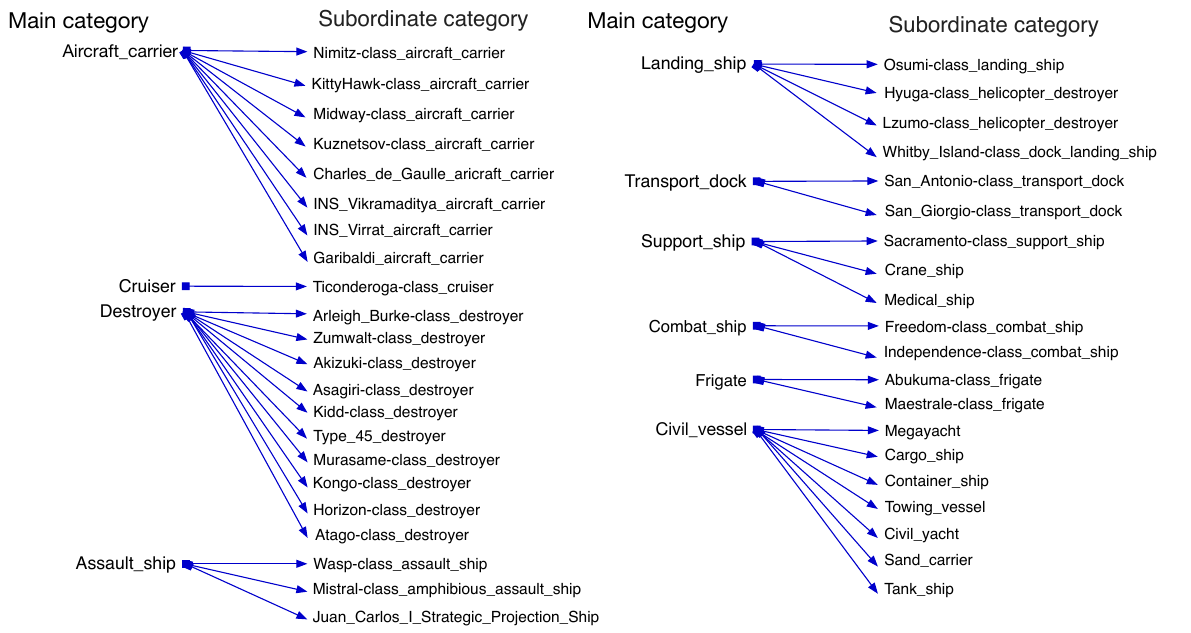
Figure 5. Label hierarchy of all categories in